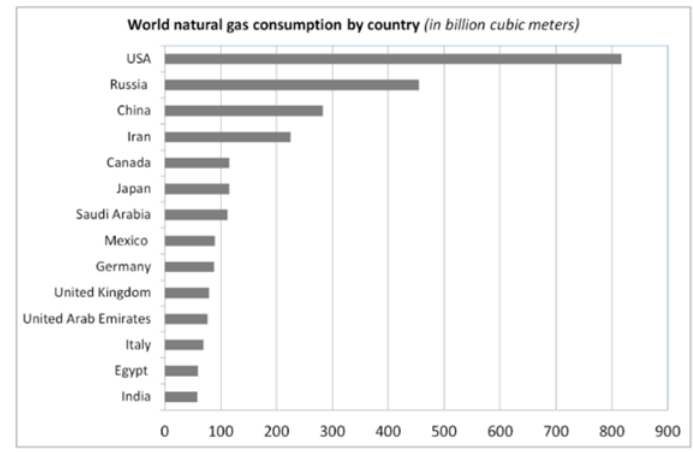
Figure 1. Top 14 consumers of natural gas in 2018.